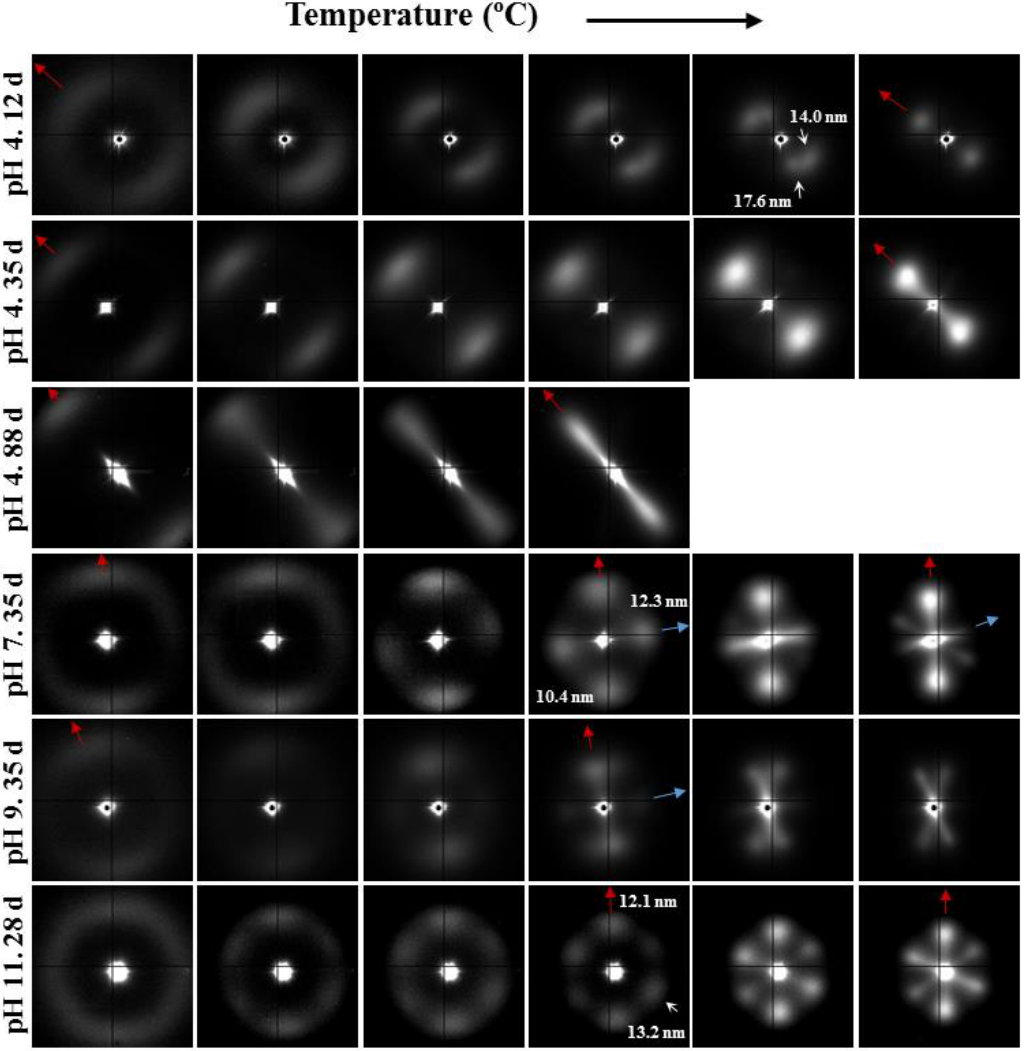
Figure 15. SAXS patterns taken during a heating run at 10 °C/min of γ irradiated GL- b -[GL- co -TMC- co -CL]- b -GL samples after being degraded in the indicated media and exposure times. Patterns in each row were acquired at increased temperatures from left to right. Red and blue arrows indicate the meridional and equatorial fiber